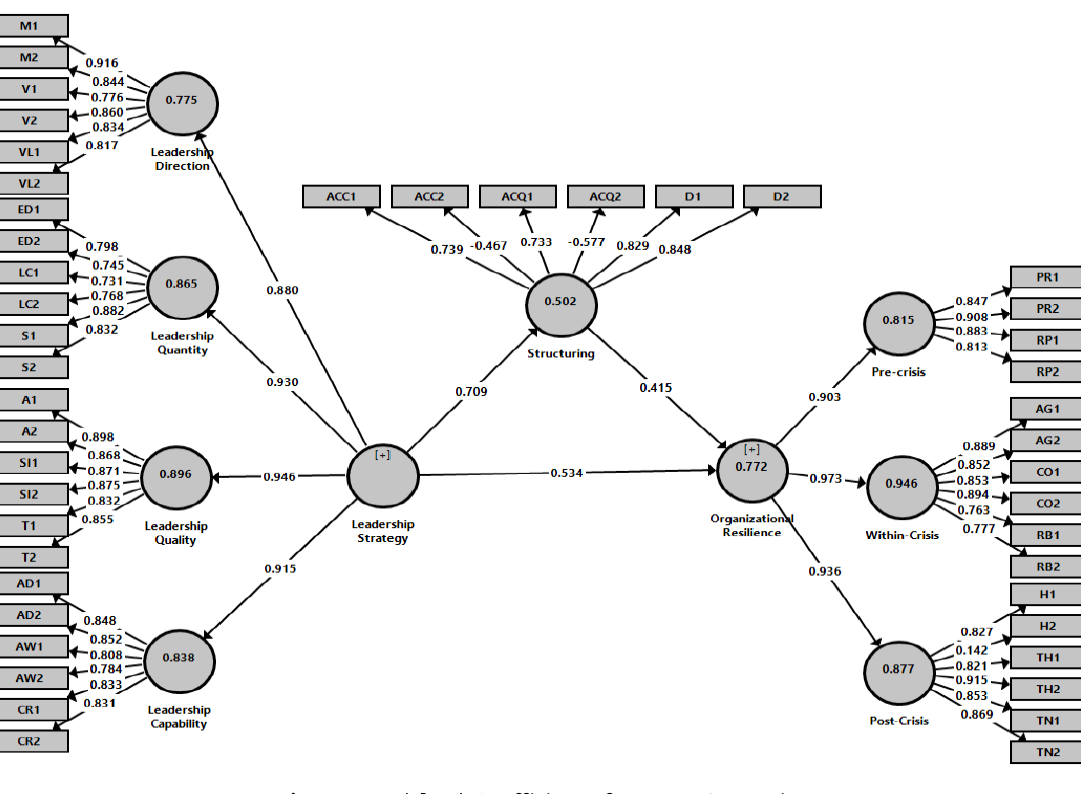
Figure 4 : Model path Coefficients of Resource